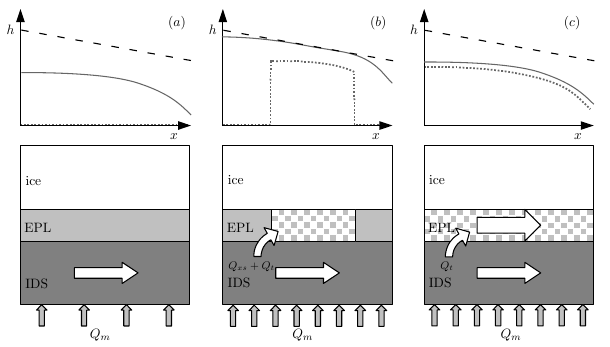
Fig. 1. Description of the coupling between the two layers of the hy- drological model. The top panels represent the water load in the IDS (solid line), in the EPL (dotted line) and the flotation limit (dashed line). The lower panels show the routing of water, (a) when the EPL is not active, (b) when the EPL is active in a transitional state (grey and white chess) and (c) when the EPL is effective.